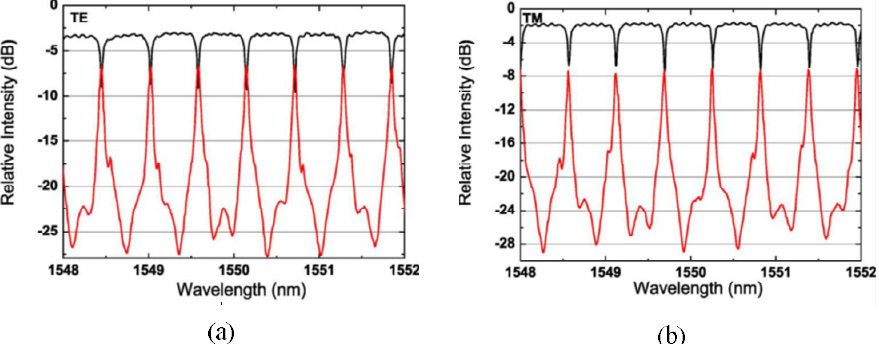
Figure 5. Measured transmission spectra of the inverted ridge waveguide microring resonator operating at ( a ) TE polarization and ( b ) TM polarization [35].